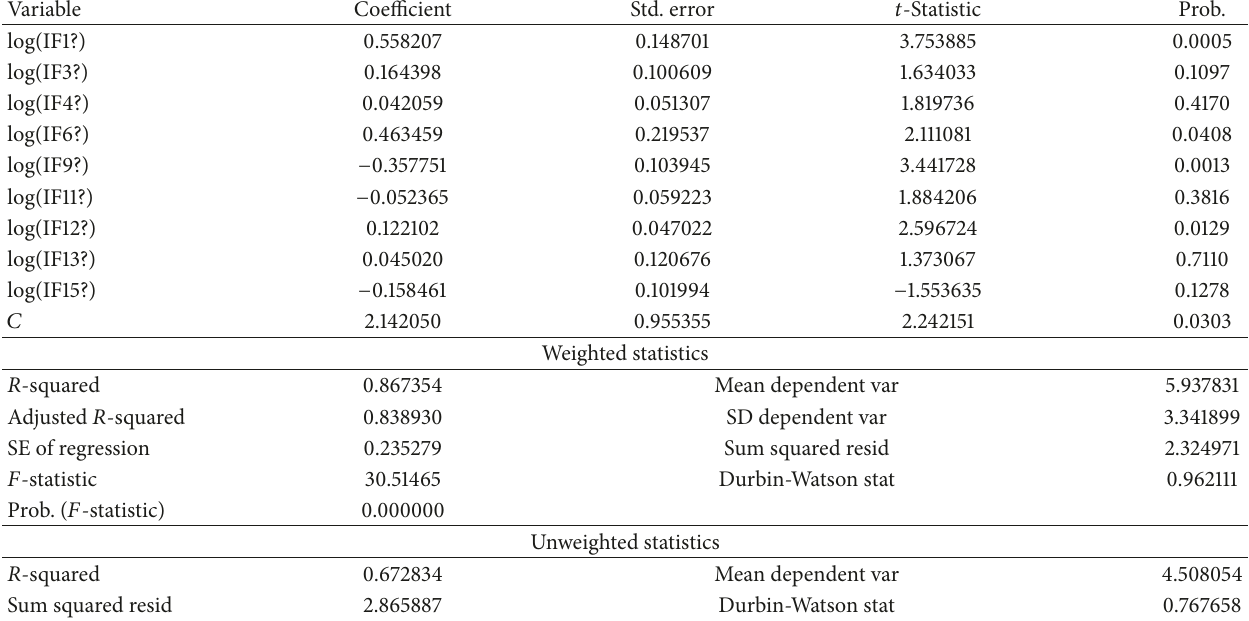
Table 7: The importance analysis